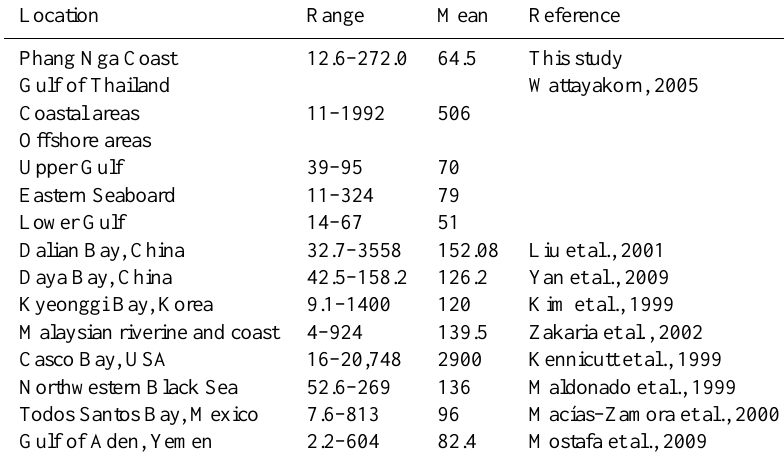
Fig. 2. The spatial distribution of sedimentary PAHs in the Khao Lak coastal area. (Numbers indicate sampling stations; the contour scale Figure 2. The spatial distribution of sedimentary PAHs in the Khao Lak coastal area. 2 represents total PAHs concentrations as labeled in the legend). (Numbers indicate sampling stations; the contour scale represents total PAHs 3 Table 1. Comparisons of P PAHs in surface sediment collected from different coastal areas and bays (ngg − 1 dry weight). concentrations as labeled in the legend) 4 Location